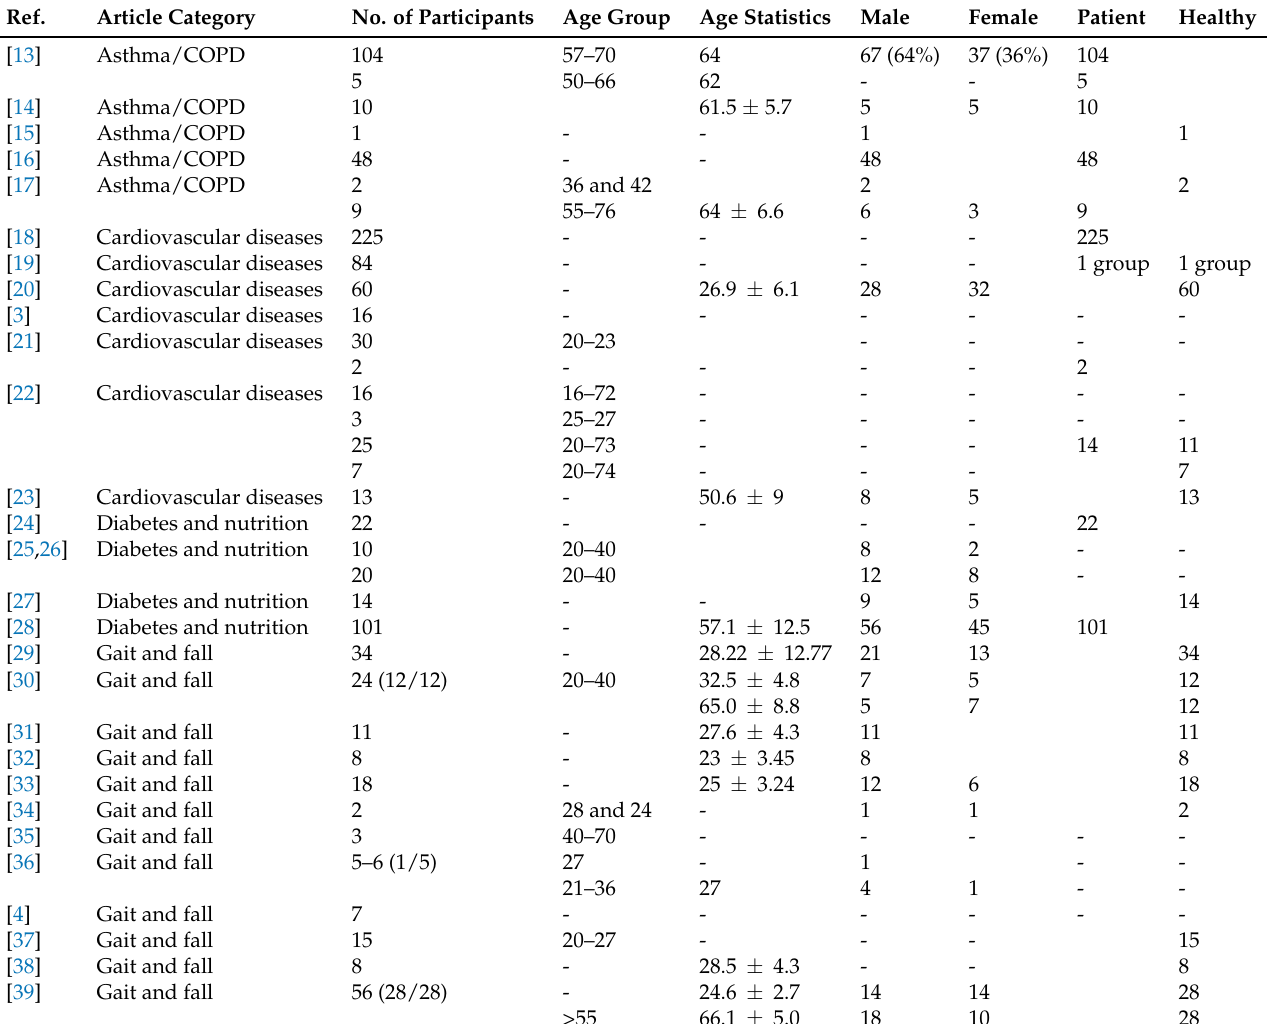
Table 3. Demographic information on conducted studies. - indicates that information is